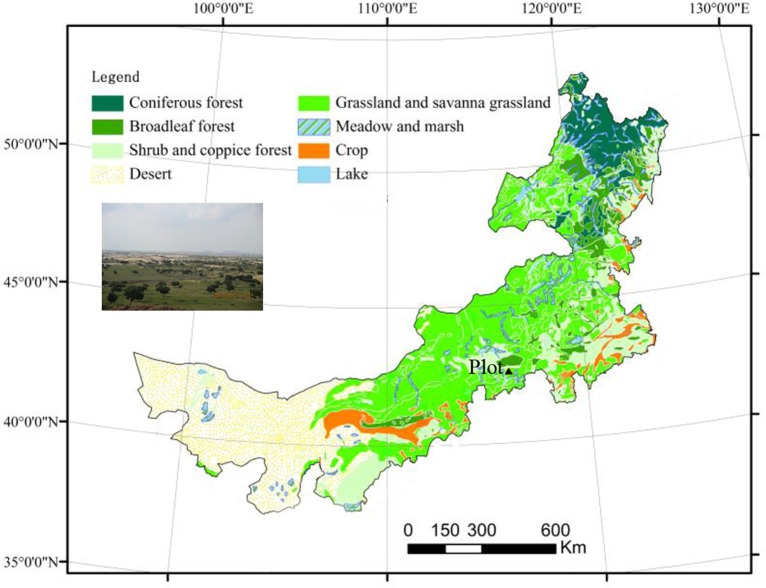
Map of the Otindag Sandy Land and the location site of the study region.